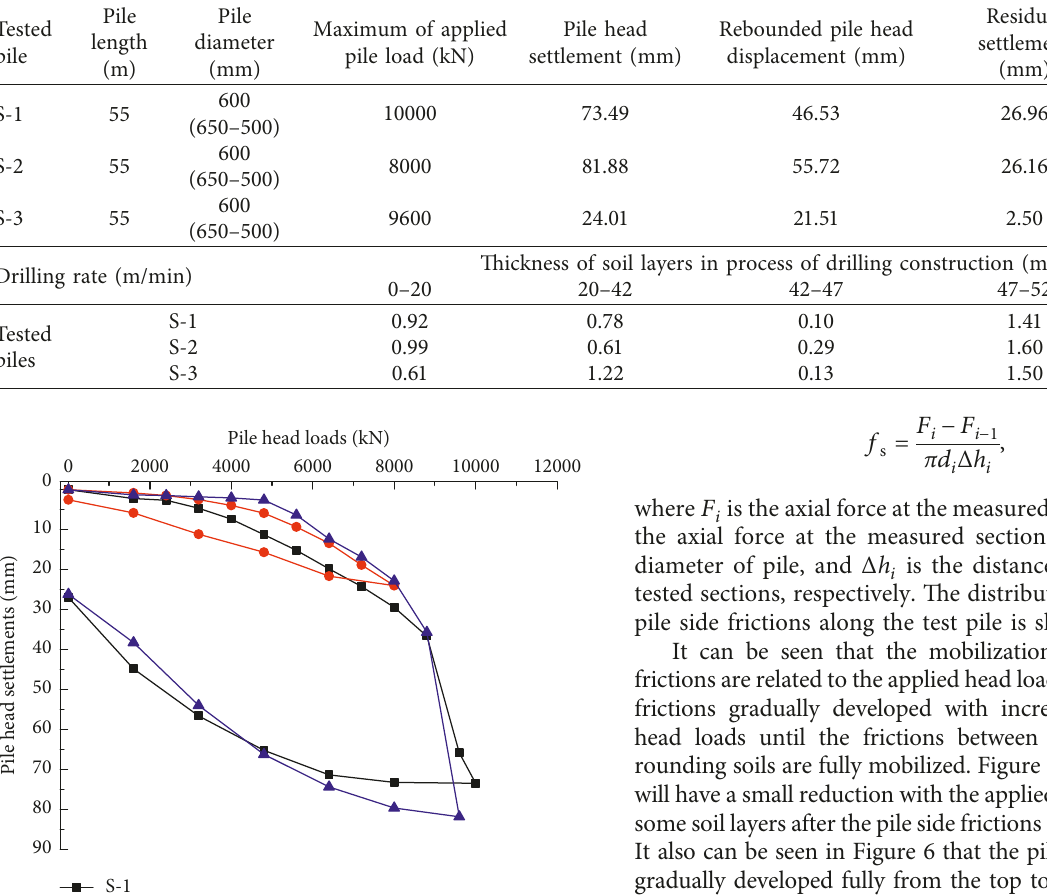
Table 2: Parameters of physical dimensions and drilling rate for the tested piles.